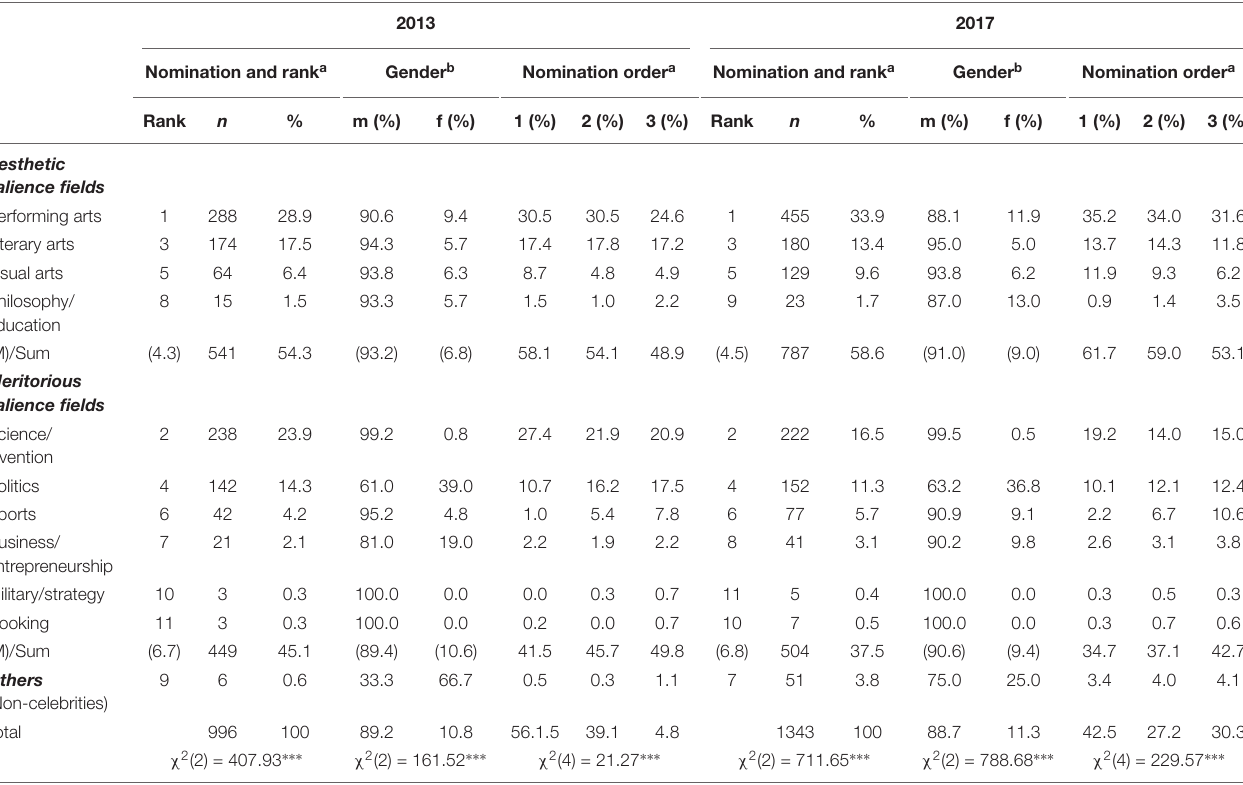
TABLE 2 | Total nominations in terms of aesthetic vs. meritorious salience fields, gender, and the nomination order in 2013 and